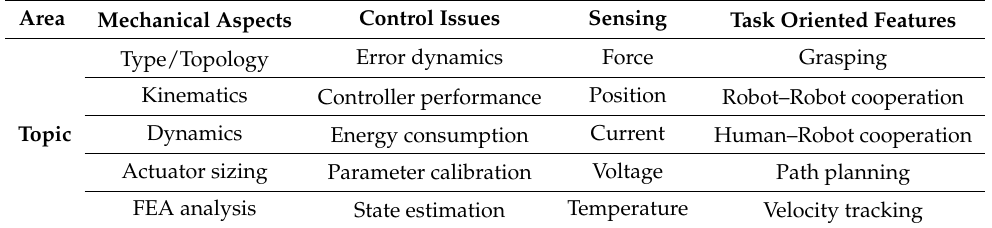
Table 1. Main topics for mechatronic systems in Figure 2.